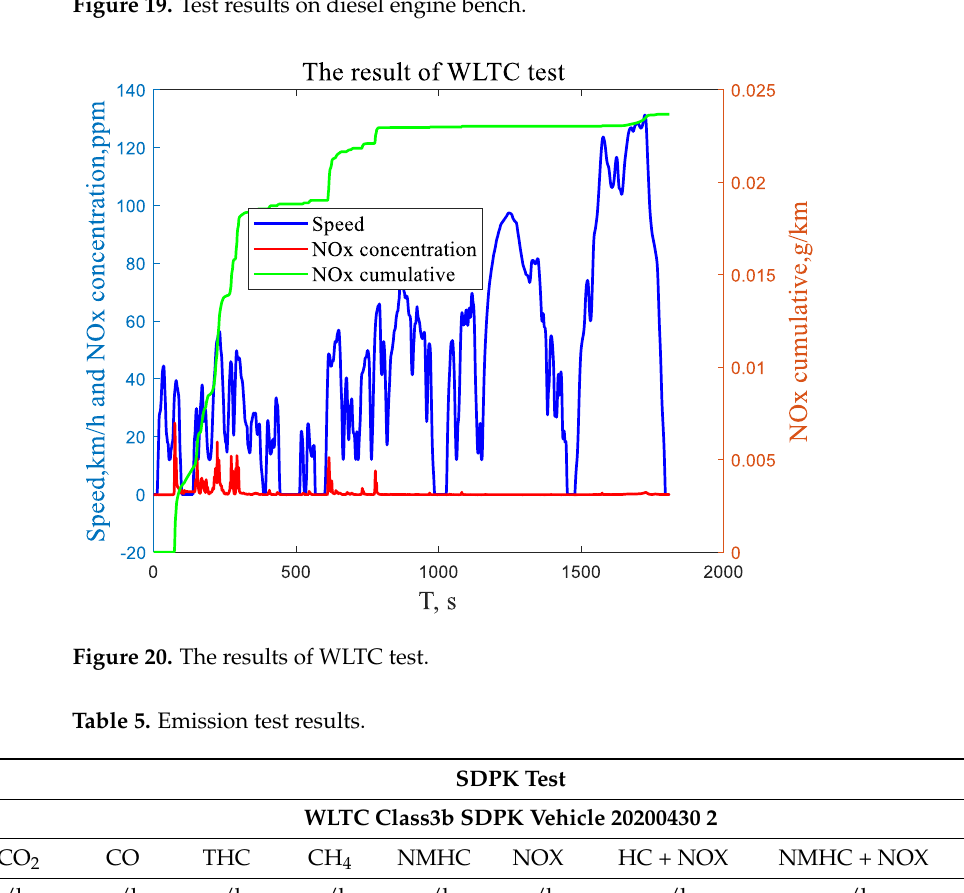
Figure 19. Test results on diesel engine bench.